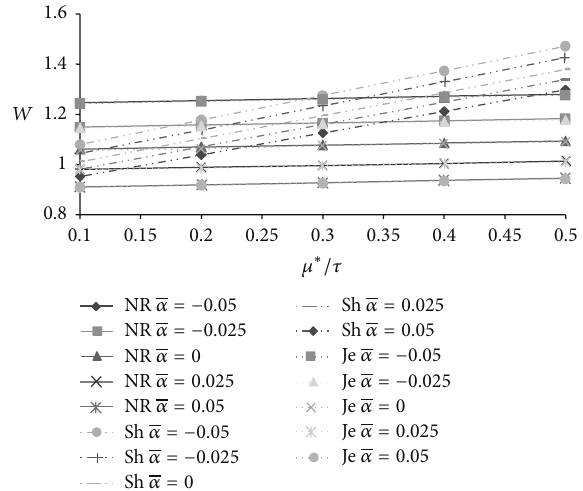
Figure 2: Variation of load carrying capacity with respect to 𝜇 ∗ and 𝜎 .